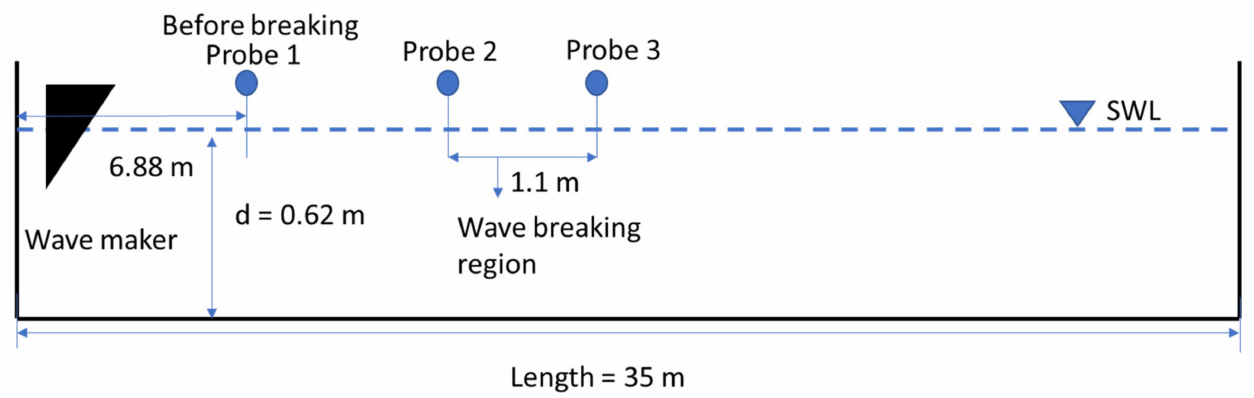
Figure 2. Experimental set up of [31] showing wave probe